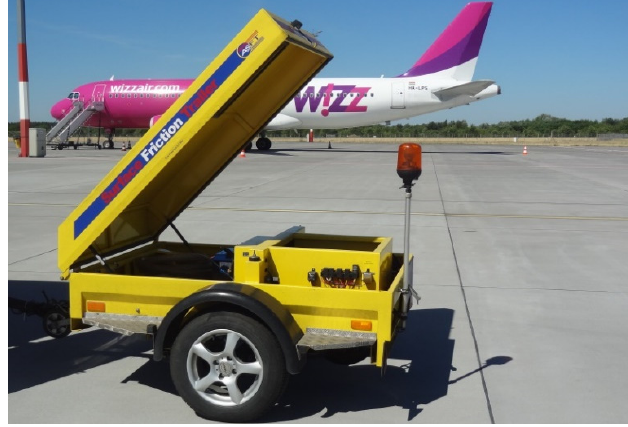
Figure 2. Airport Surface Friction Tester on Trailer T-10.